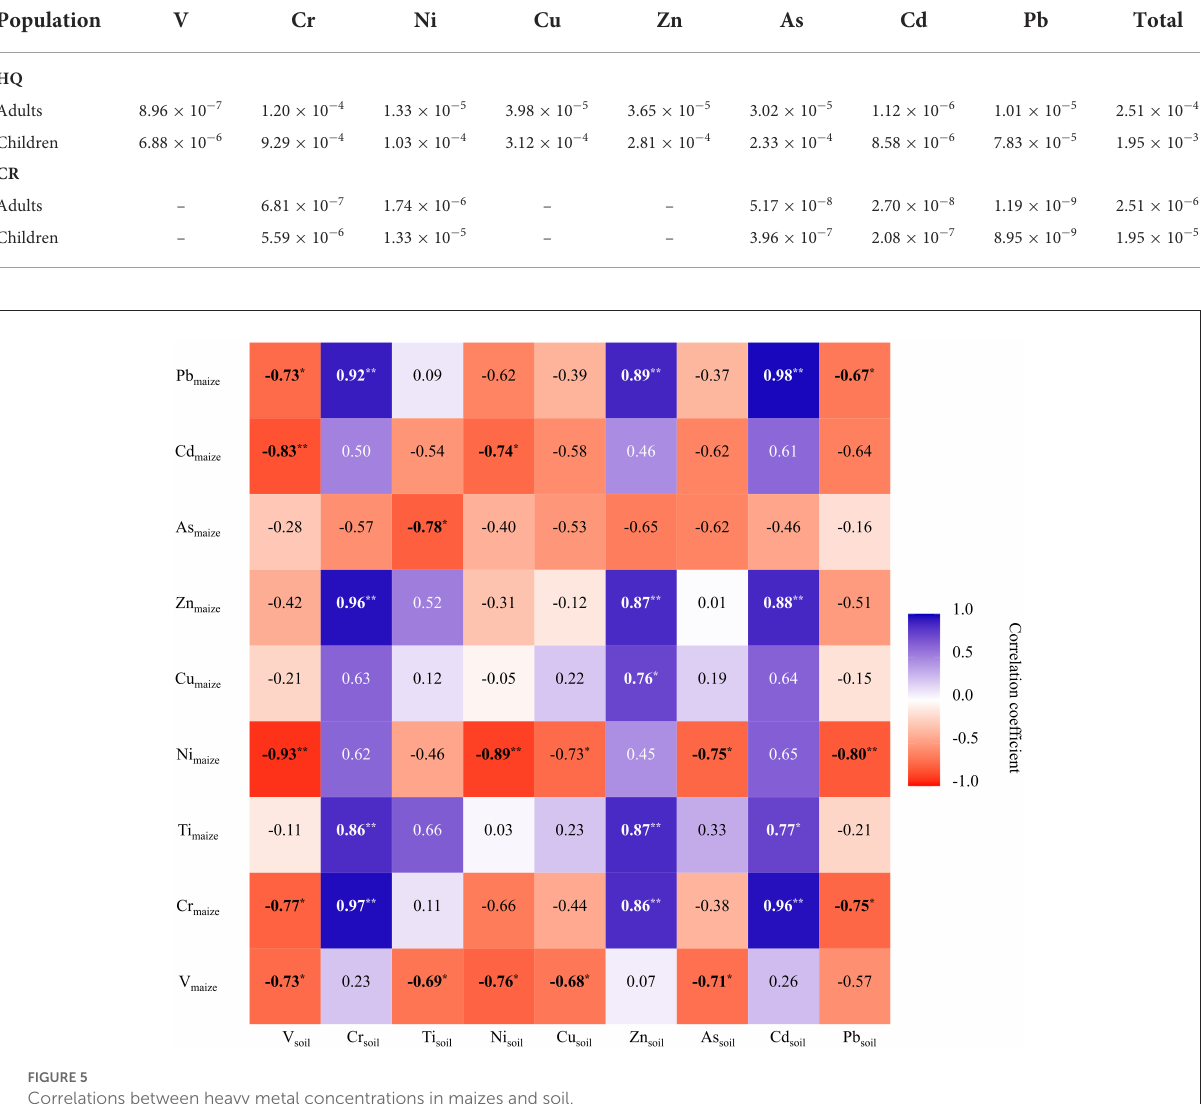
TABLE 3 Estimation of non-carcinogenic (Hazard quotient, HQ; Hazard index, HI) and carcinogenic risks (CR) posed by heavy metal in maize via Monte Carlo simulation.